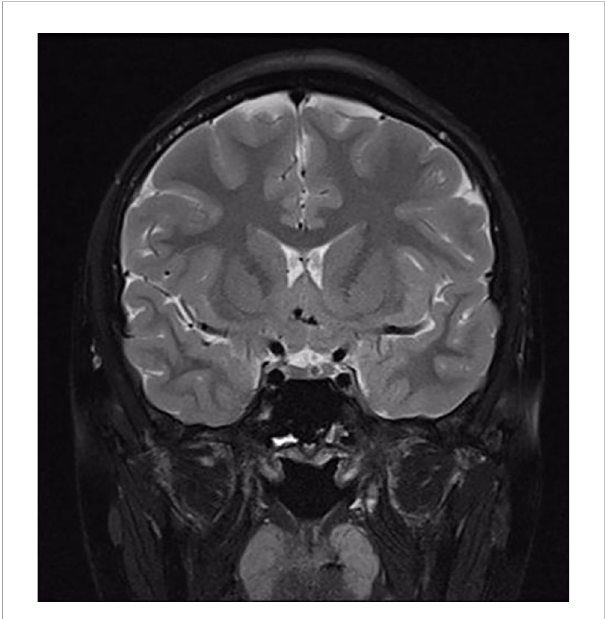
FIGURE 2 MRI image of the pituitary gland. A nodule in the lower left pituitary is observed.